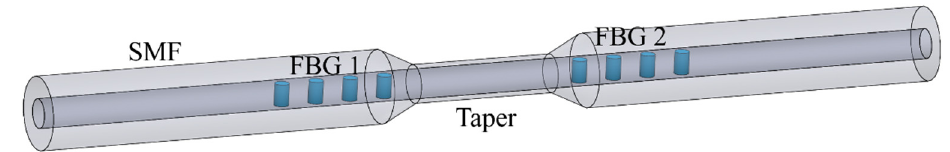
Figure 5. The schematic diagram of tapered PS-FBG.